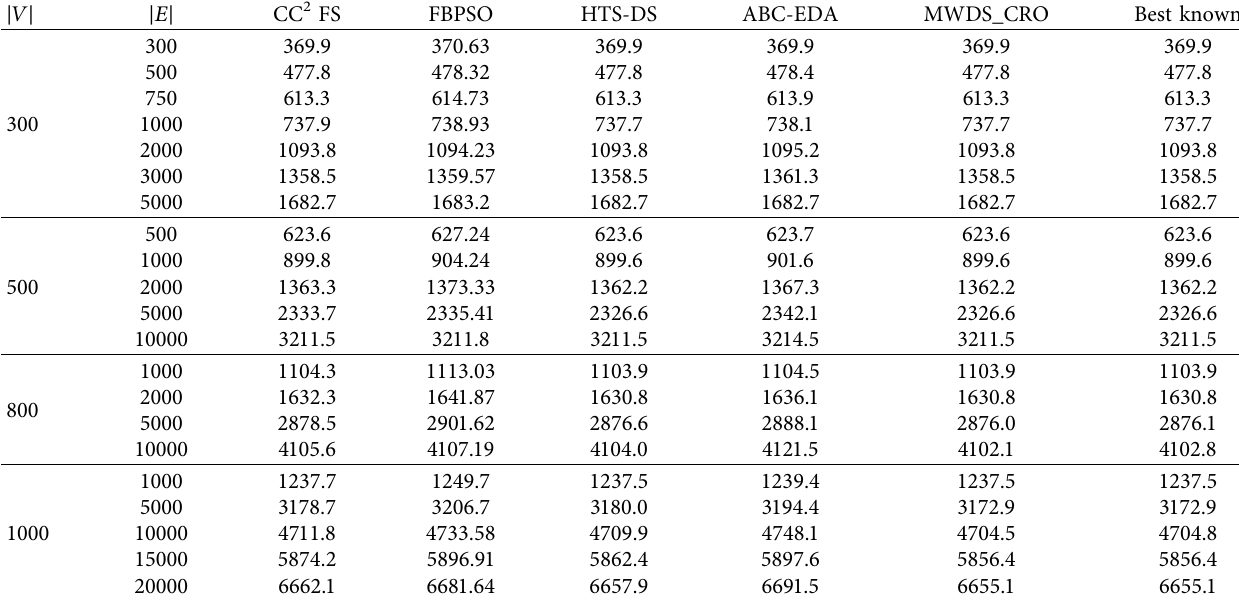
Table 6: Type TII class LPI-comparison of MWDS_CRO for various parameters with recent state-of-the-art